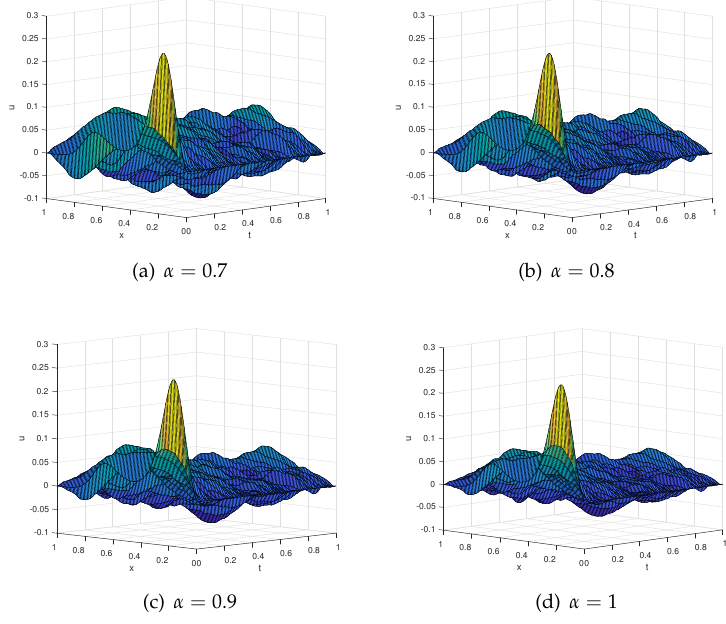
Figure 4. The approximation solutions of Example 2 (case (1)) with σ = 1.